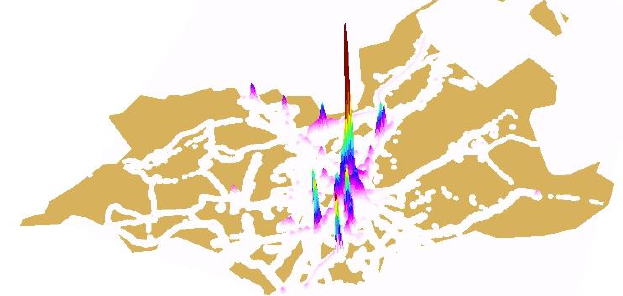
Figure 1. Kernel density visualization of Geneva movement